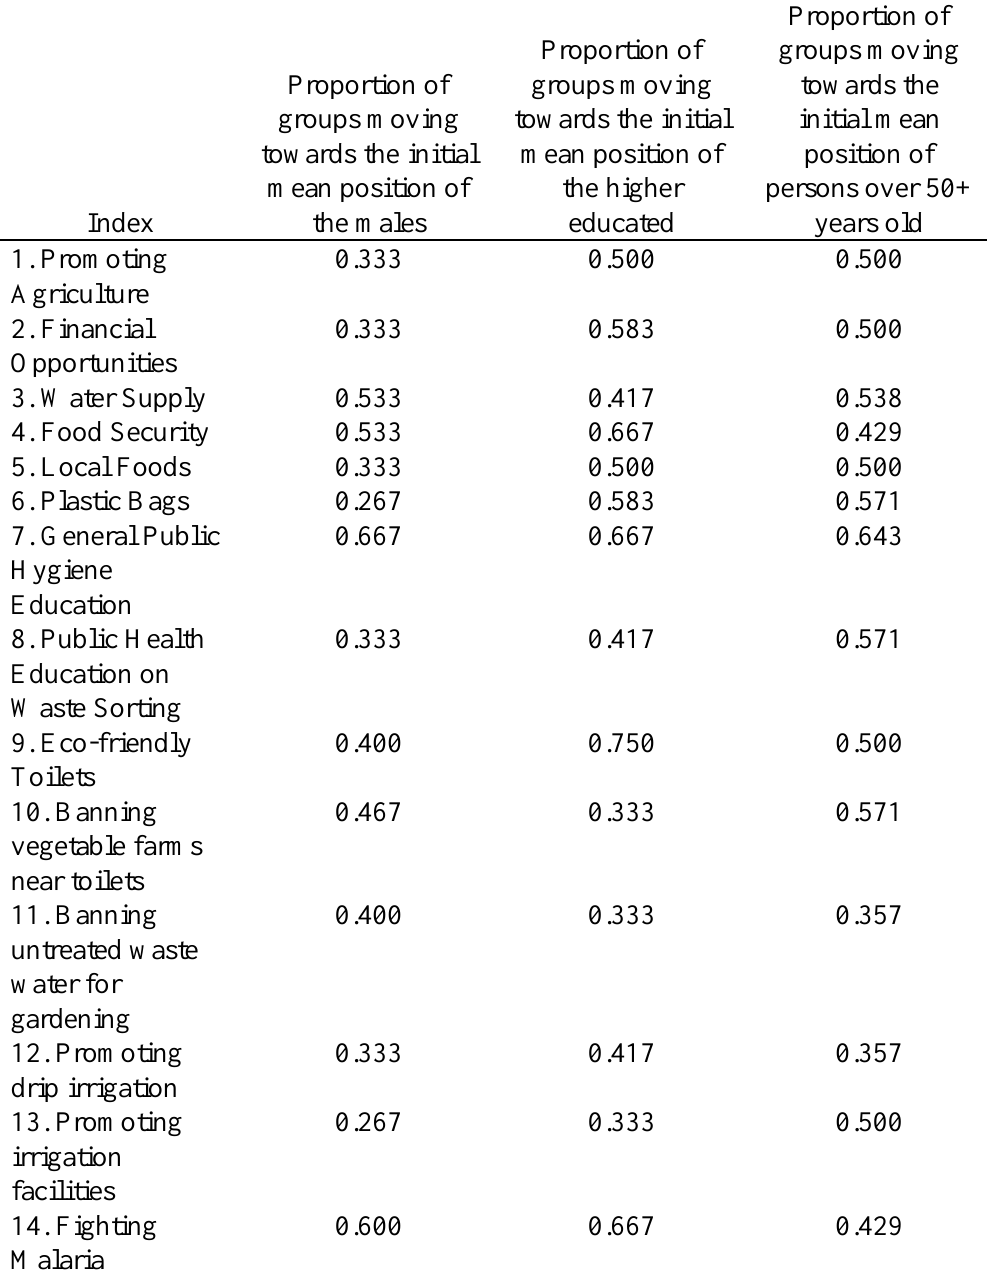
Table 6: Inequality in the Small